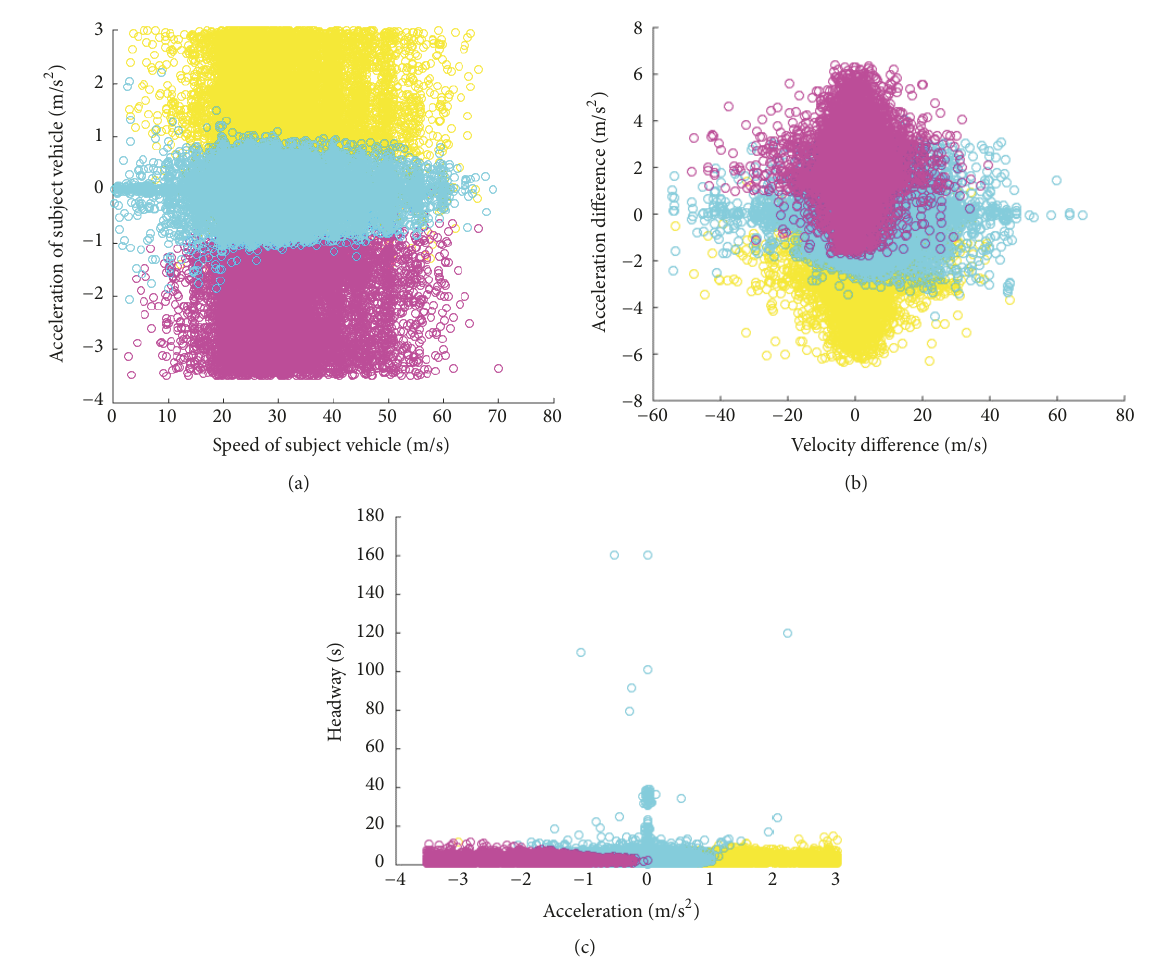
Figure 2: Driving types clustered under the condition of unblocked traffic. Table 1: The distribution of feature vector of different driving types in an unblocked traffic state.